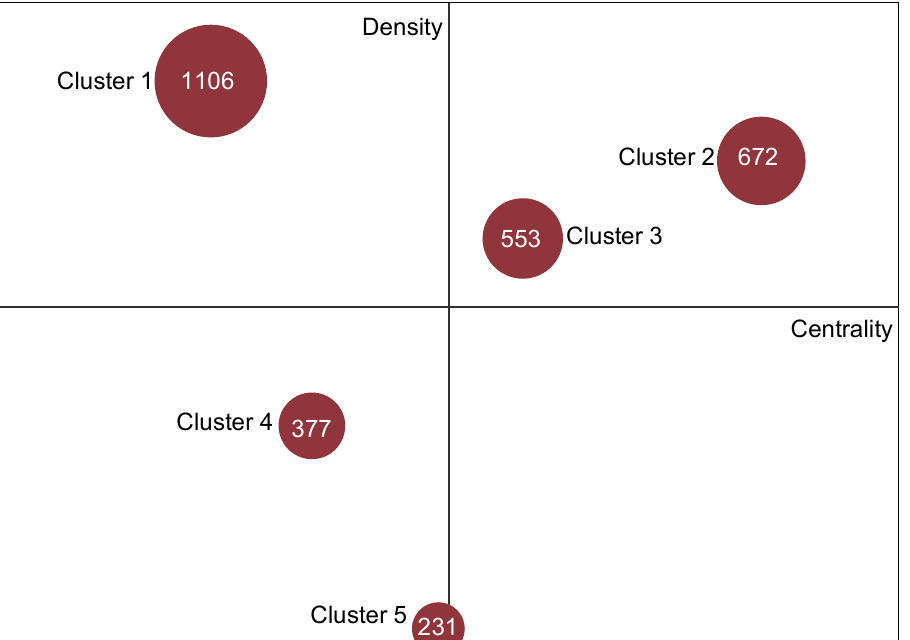
Figure 5. Strategic diagram based on number of times the papers was cited. As shown in Figures 4 and 5, Cluster 2 and Cluster 3 are located in the first quadrant, with both relatively high density and centrality, showing that these clusters not only have